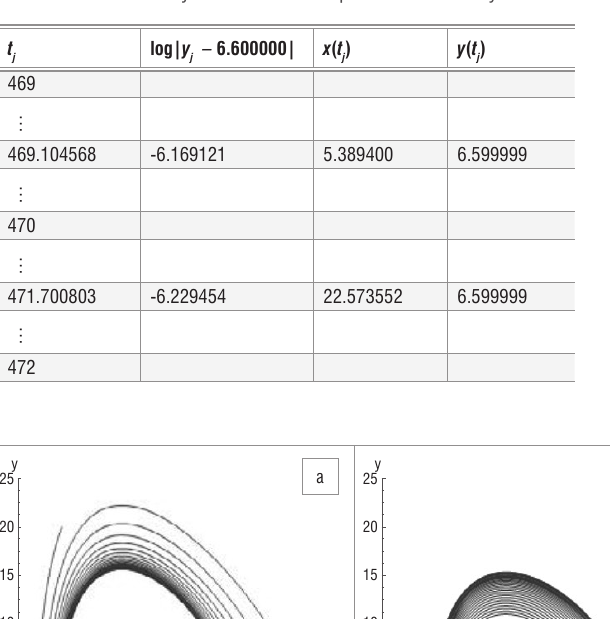
Figure 5: Convergence of sequences { u xy- plane. An accuracy to six decimals for points on the limit cycle